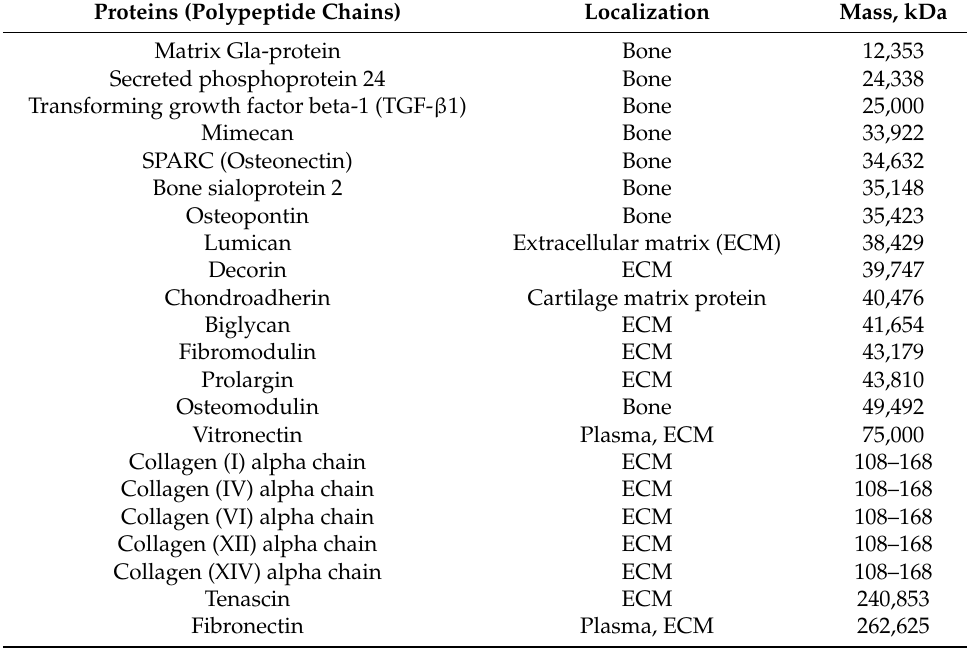
Table 1. List of organic components identified in the analysis of demineralized human spongiosa Lyoplast ®